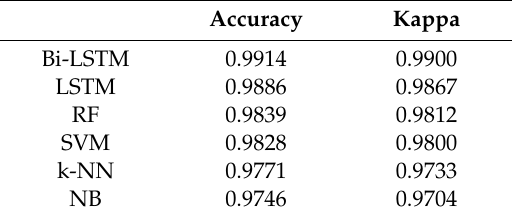
Table 2. Mean accuracy, Kappa, and F-score values for the models evaluated.